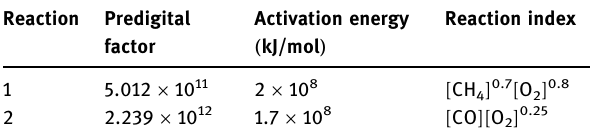
Table 1: Chemical kinetics parameters Reaction Predigital Activation energy ( kJ/mol ) factor